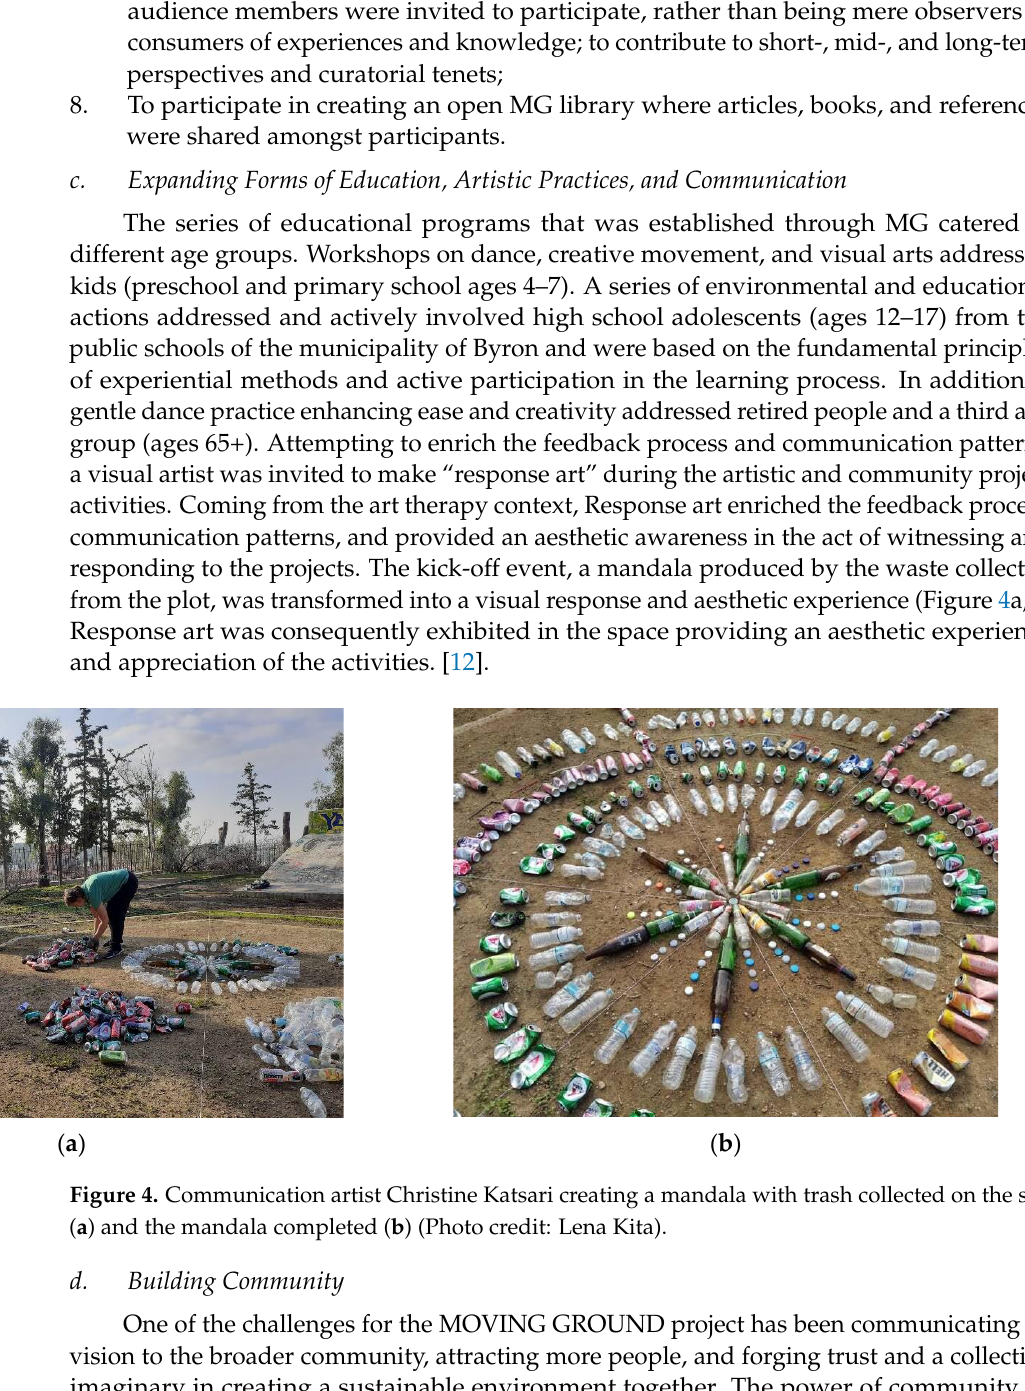
Figure 5. A seed exchange and germinating techniques seminar at the terrace ( a ) and planting seed- lings by the workshop participants ( b ), 23 January 2021. (Photo credit: Monica Vaxevani). 4. Milestone Actions and Events A multitude of projects and events unfolded during the twelve-month period of the MG project. Some of the most relevant events which outlined the methodology imple- mented, were the following: A Permaculture workshop (theory and practice taught by Tina Lymperis). The work- shop disseminated permaculture principles and involved participants in planting season- ally appropriate nasturtiums (Tropaeolum majus) around the Duncan center as a first ges- ture of common care and collective thinking.